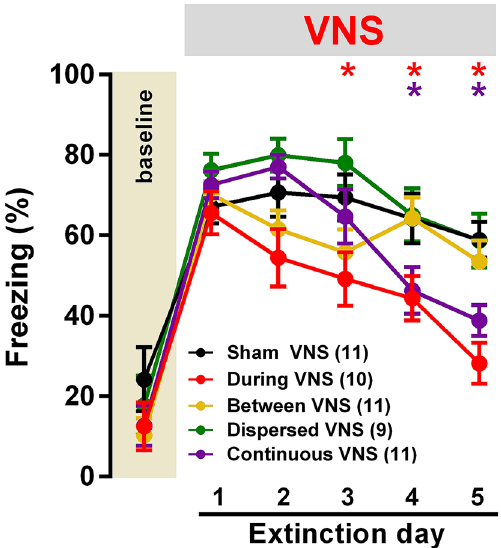
Figure 2. VNS reverses the impairment in extinction learning after severe stress and promotes fear reduction. Sham VNS rats failed to extinguish conditioned fear over 5 days of extinction training. Rats that received between VNS or dispersed VNS did not display an enhancement in extinction compared to Shams VNS rats. Significant reduction in conditioned fear in rats that received during VNS or continuous VNS indicates